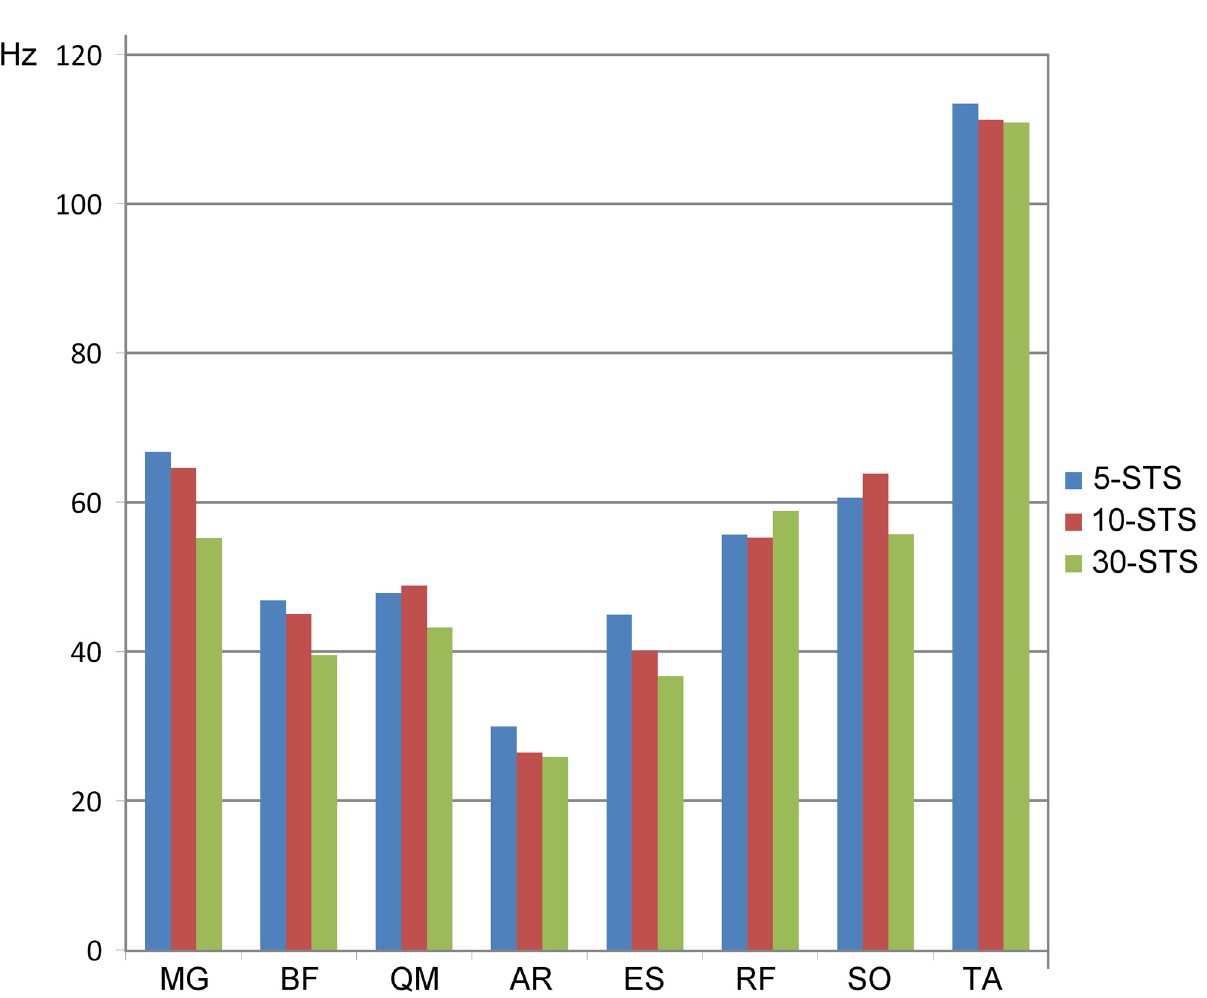
Fig 3. MF average for eight muscles in each STS task (Hz).